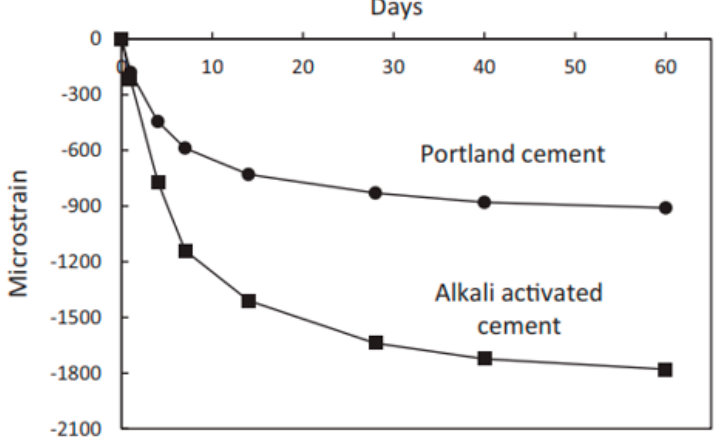
Figure 19. Shrinkage with respect to time of both OPC and alkali activator binder [149].